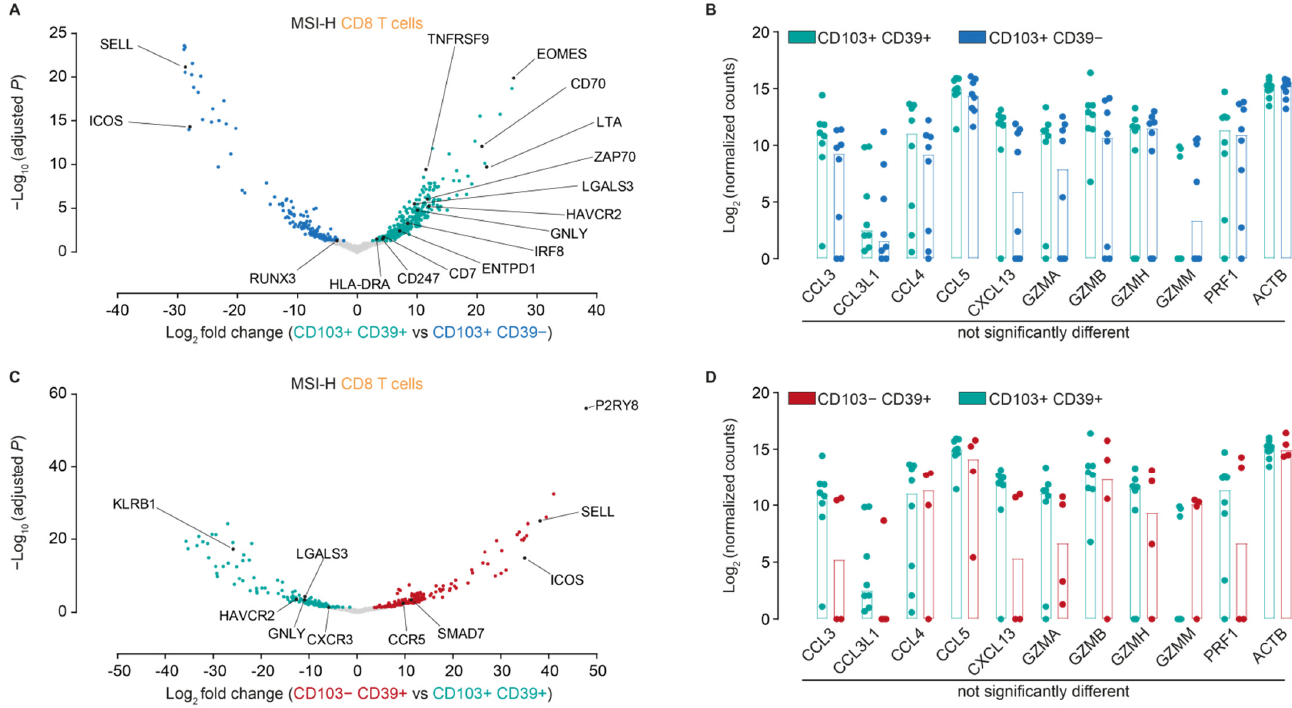
Figure 2. Differentially expressed genes between ( A ) CD103+ CD39+ and CD103+ CD39 − , and ( C ) CD103 − CD39+ and CD103+ CD39+ cells. Genes with a Benjamini-Hochberg FDR < 0.1 were selected as significantly changed. ( B , D ) Log2-normalized gene expression counts for the indicated genes in the CD8+ T cell subsets as determined by mRNA sequencing ( n = 3 patients; >2 technical replicates per population).